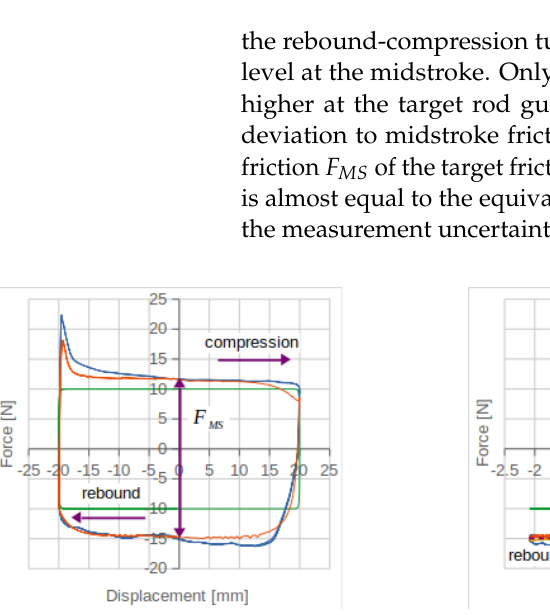
Figure 14. Comparison of the force displacement graphs ( left ) and the force speed graphs ( right ) of the 14 mm target rod FEM simulation and SFP measurement of the friction behavior of the rod guide assembly/rod single friction point.